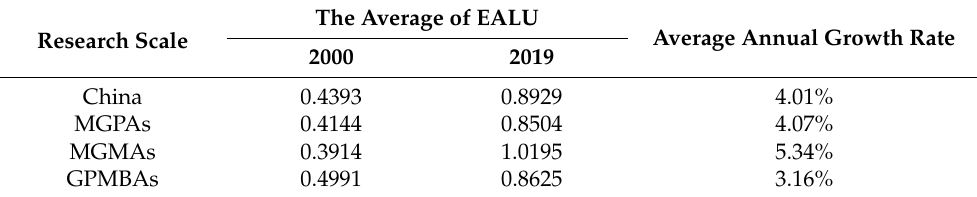
Figure 2. Average value of EALU in China, main grain producing areas (MGPAs), main grain marketing areas (MGMAs), and grain producing and marketing balance areas (GPMBAs) from 2000 to 2019. Table 6. Average annual growth rate of the mean of EALU in China, main grain producing areas (MGPAs), main grain marketing areas (MGMAs), and grain producing and marketing balance areas (GPMBAs) from 2000 to